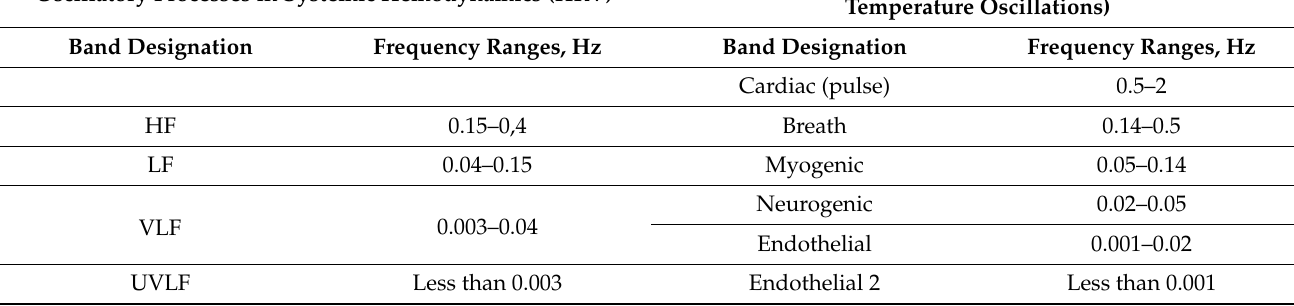
Table 1. Comparison of the frequency ranges of oscillations identified in the analysis of heart rate—HRV, laser Doppler flowmetry (LDF) signals, temperature oscillations [6,7]. Oscillatory Processes in Blood Microcirculation (LDF and Oscillatory Processes in Systemic Hemodynamics (HRV) Temperature